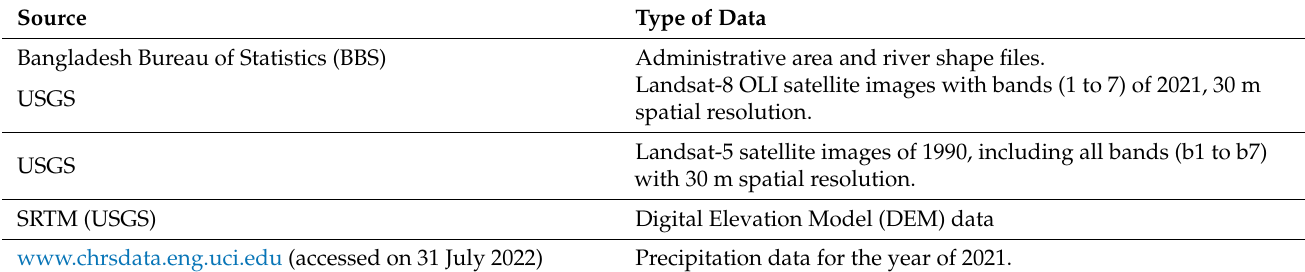
Table 1. Data used for LULC classification and predicting lands vulnerable for agricultural activities. Source Type of Data Bangladesh Bureau of Statistics (BBS) Administrative area and river shape files. Landsat-8 OLI satellite images with bands (1 to 7) of 2021, 30 m USGS spatial resolution. Landsat-5 satellite images of 1990, including all bands (b1 to b7) USGS with 30 m spatial resolution. Digital Elevation Model (DEM)